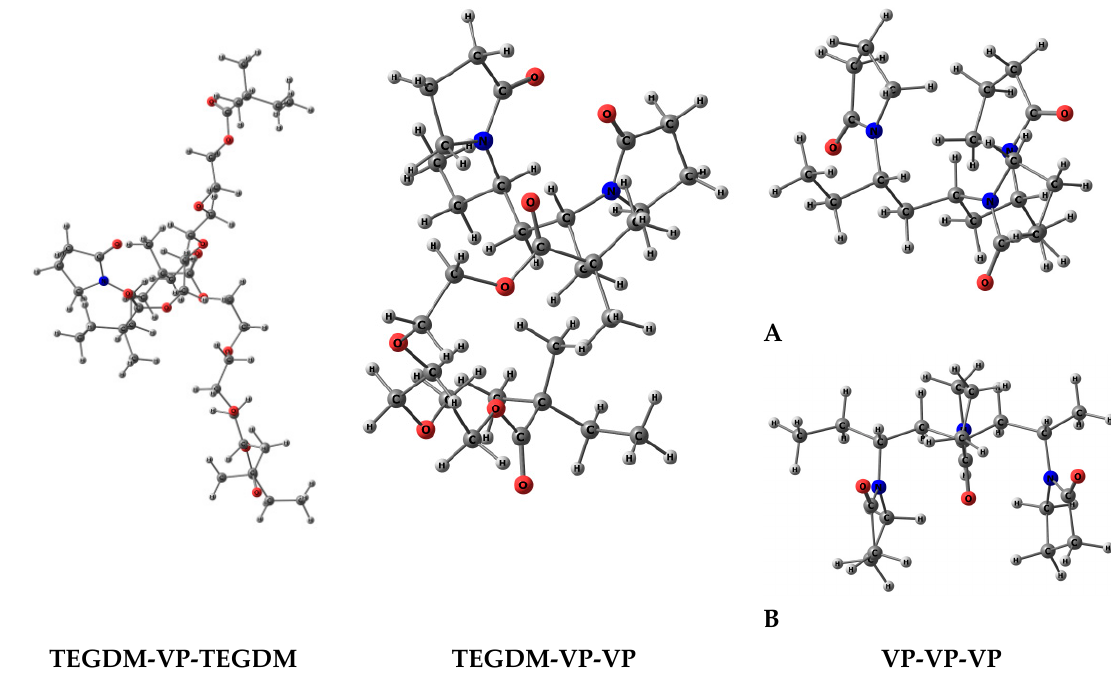
Figure 5. Optimized geometries of considered statistically possible sequences of the N - Optimized geometries of considered statistically possible sequences of vinylpyrrolidone-triethylene glycol dimethacrylate (VP-TEGDM) copolymer.